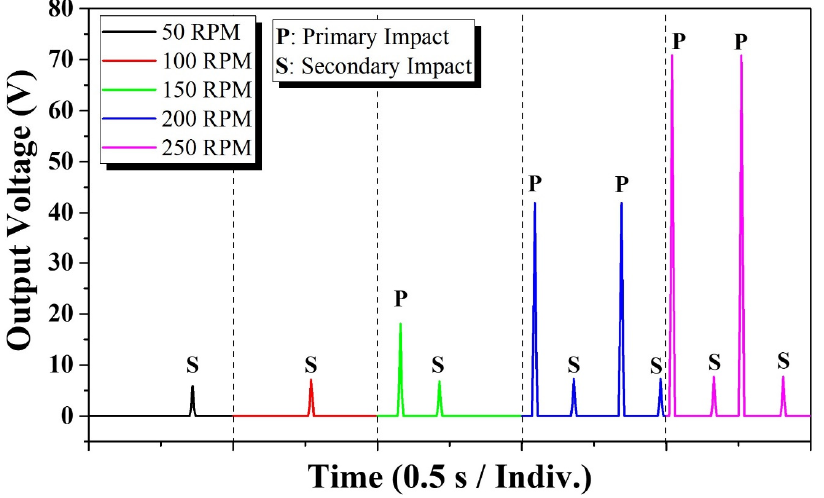
Figure 7. Variation of output voltage for hammer-impact-driven power generator under optimal load resistance as a function of impeller rotation speed.